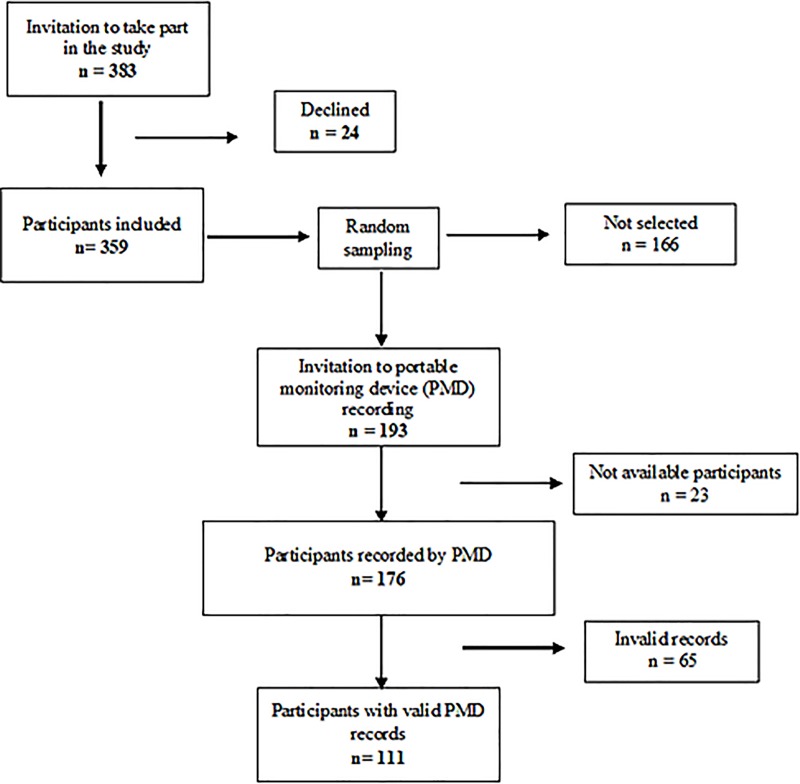
Flow chart of the inclusion of participants.PMD: Portable Monitoring Device.